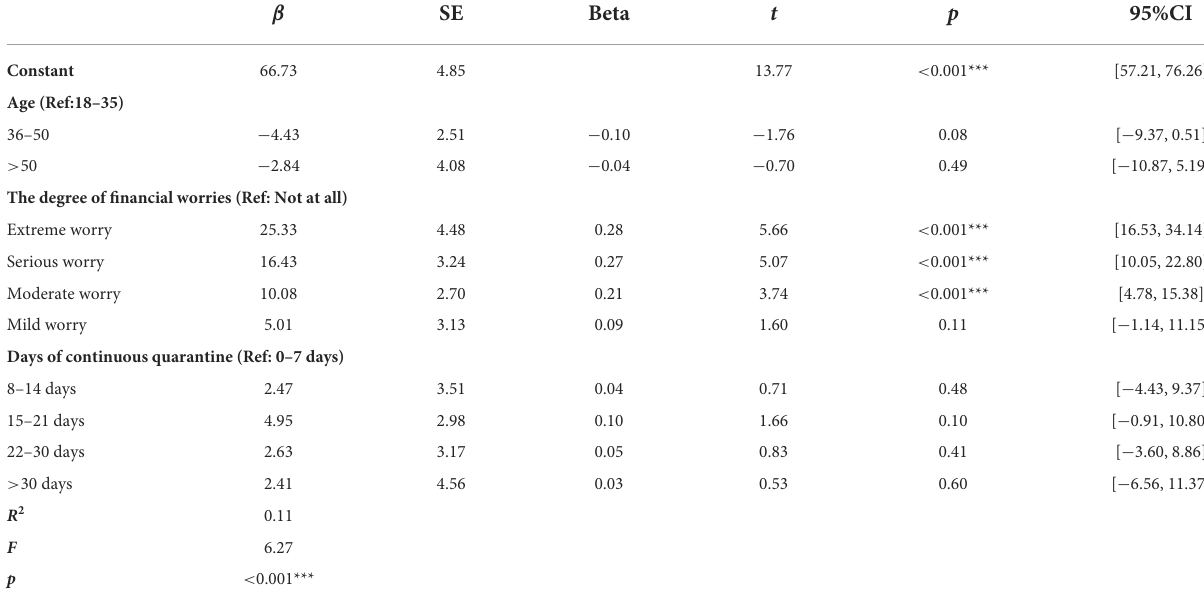
TABLE 3 Multiple linear regression analysis on total stress